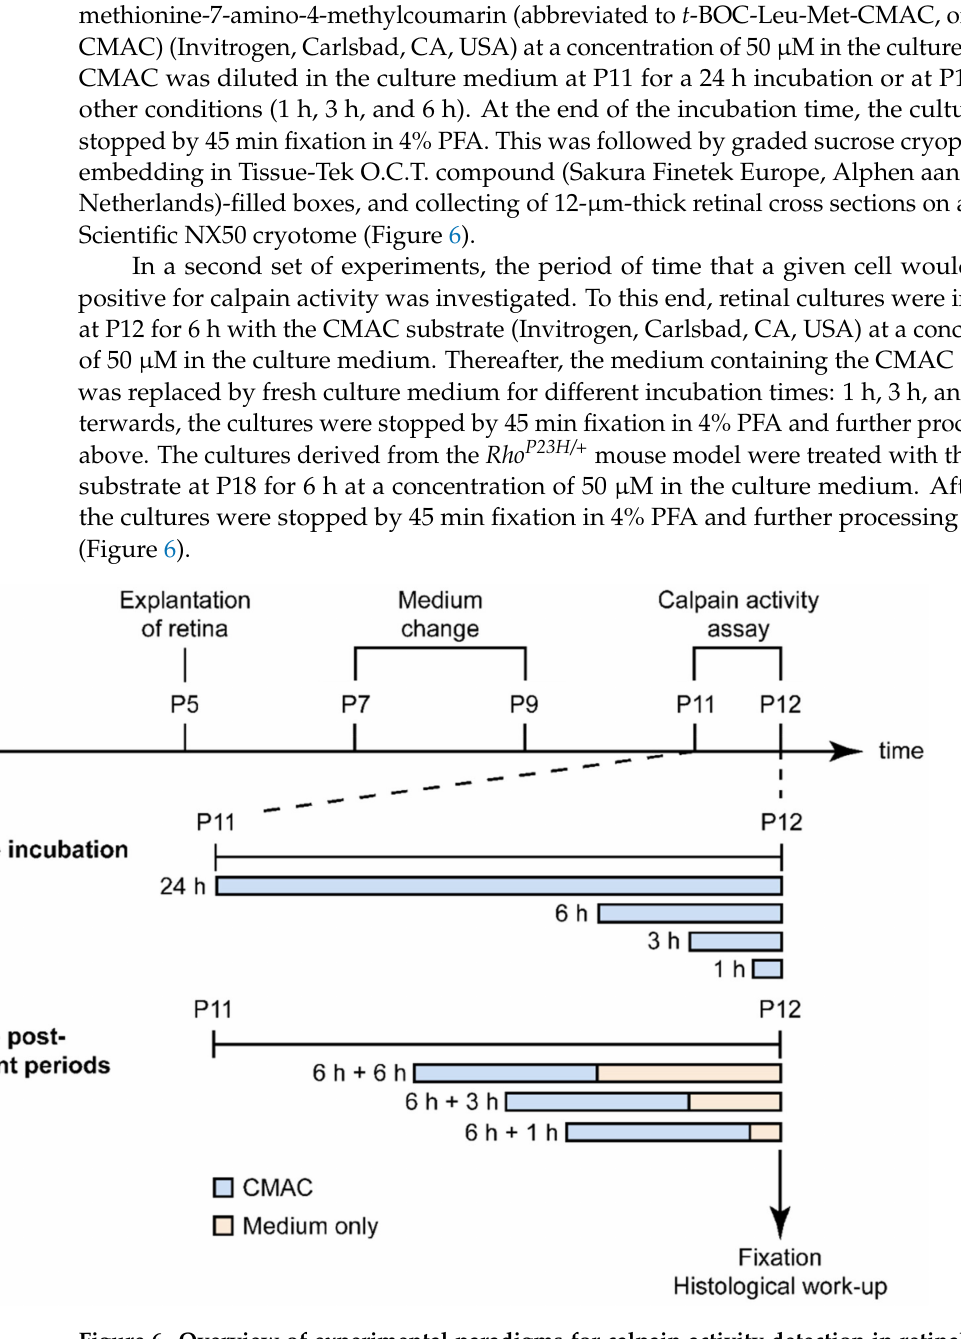
Figure 6. Overview of experimental paradigms for calpain activity detection in retinal explants. The organotypic retinal explant cultures were derived from either wild-type or rd1 animals at postnatal day (P) 5. The culture medium was changed every second day, and retinal explants were